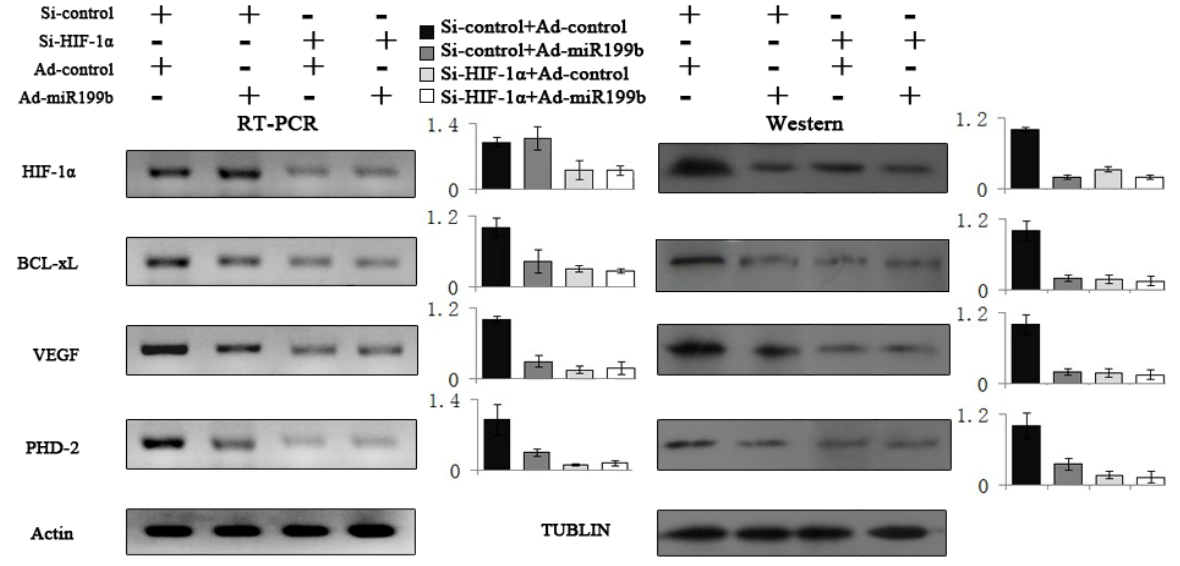
Figure 5. Effects on HIF-1 α and its target genes by artificial over-expression of miR-199b